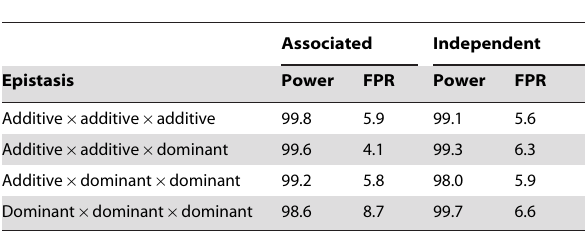
Table 13. Power and false positive rates (FPR) for the detection of three-locus epistasis among associated and independent SNPs for 1000 cases and 1000